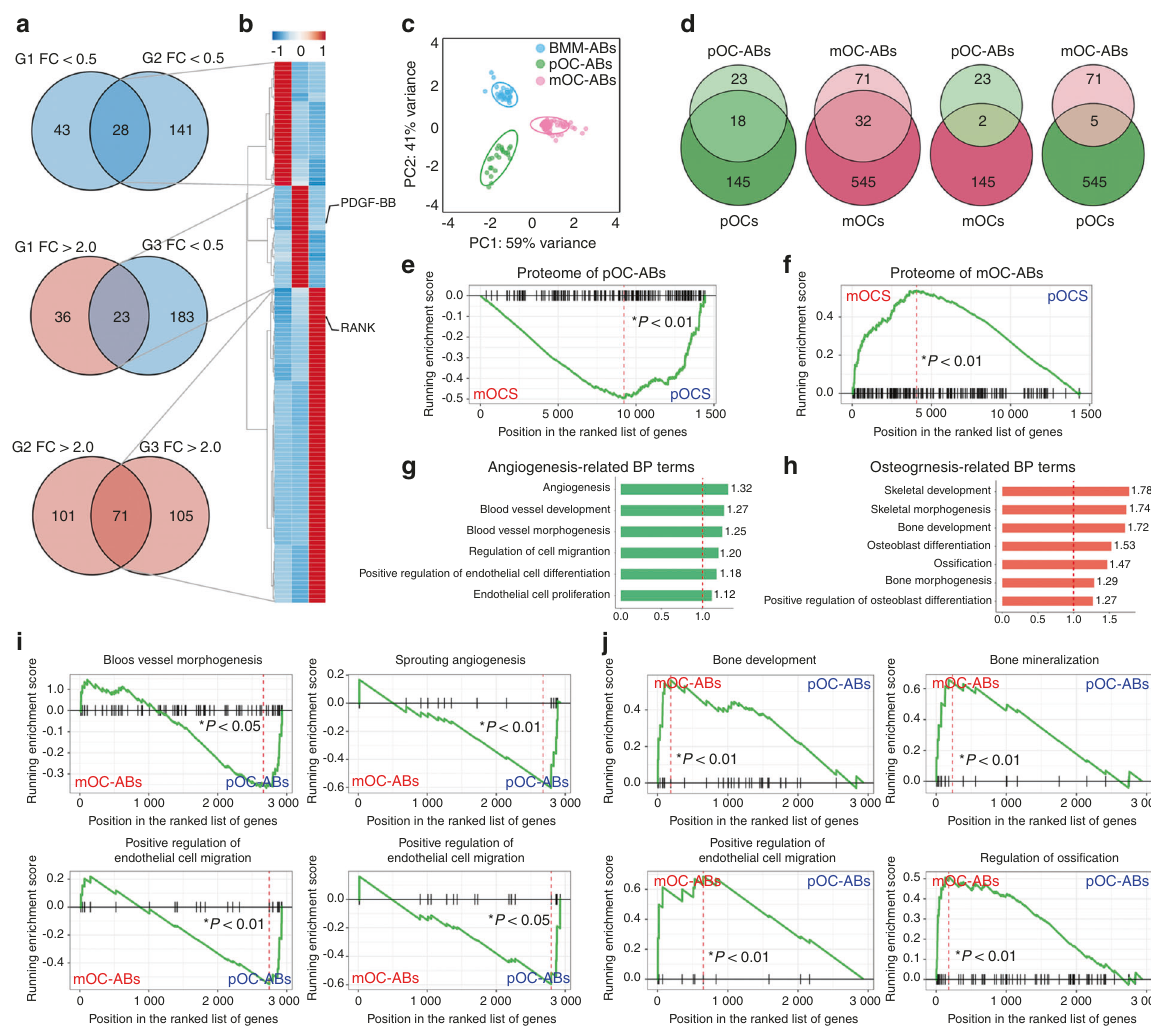
Fig. 3 The similarities of the proteomic signatures of ABs with those of their parental cells indicate functional similarities. a Venn diagram analysis of the three comparison groups identi fi ed the proteomic signatures of the different types of ABs. The threshold FC was >2.0 or <0.5. (G1, pOC-ABs versus BMM-ABs; G2, mOC-ABs versus BMM-ABs; G3, mOC-ABs versus pOC-ABs). b The proteomic signatures of ABs derived from BMMs, pOCs, and mOCs are shown as a heat map. Among the proteins, PDGF-BB and RANK were signature proteins of pOC-ABs and mOC- ABs, respectively. c PCA of the protein expression signatures of the three types of ABs. The elliptical solid lines indicate the 95% con fi dence intervals. d Venn diagrams comparing the candidate protein signatures of ABs with the gene signatures of their corresponding parental and nonparental cells. GSEA plots showed the relationship of the whole-proteome signatures of ( e ) pOC-ABs and ( f ) mOC-ABs with the gene expression pro fi les in the corresponding parental cells. GO analysis revealed that ( g ) DUPs in pOC-ABs were enriched in angiogenesis- associated BP terms, whereas ( h ) DUPs in mOC-ABs were predominantly enriched in osteogenesis-associated BP terms. GSEA showed that ( i ) enriched proteins in pOC-ABs were more closely associated with angiogenesis-related biological processes, whereas ( j ) enriched proteins